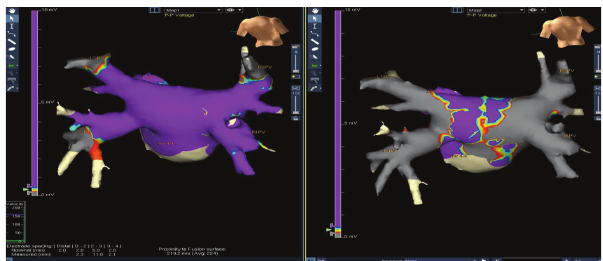
Figure 1: High-density voltage map of the left atrium using elec- troanatomic mapping, NavX Velocity 3.0, before and after the proce-